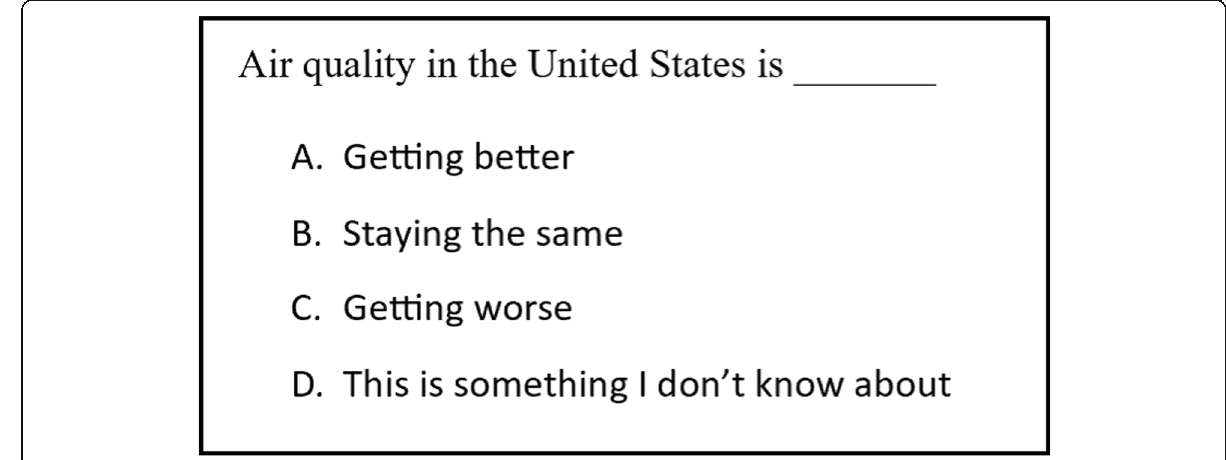
Fig. 1 Mind-mapping instructional task initial